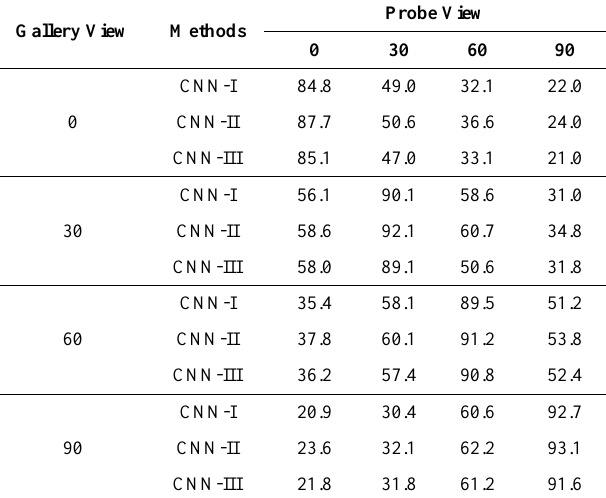
Table 3. Correct Classification Rate for OUISIR-MVLP Dataset Gallery